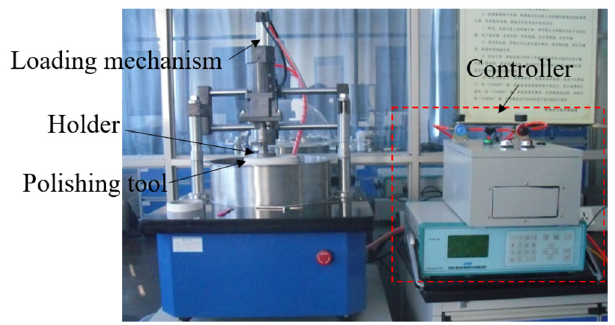
Figure 4. Experimental setup.